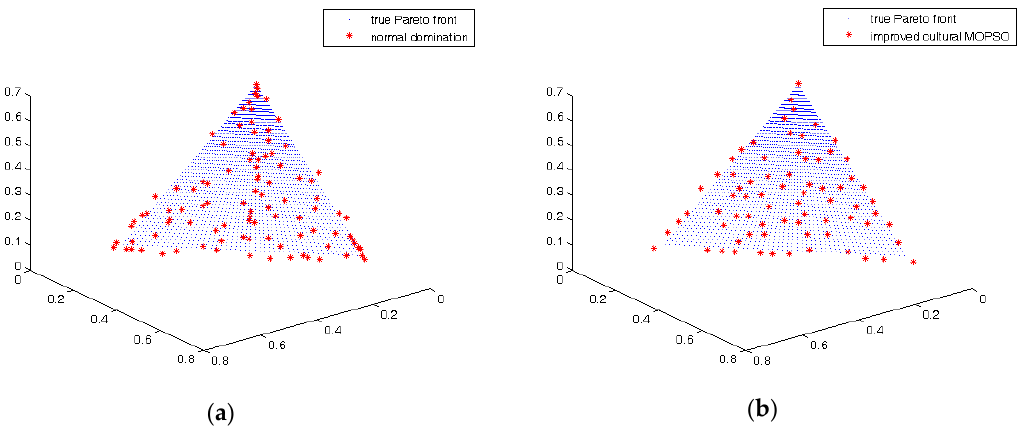
Figure 6. Pareto fronts for DTLZ1: ( a ) the Pareto fronts obtained using normal domination criterion; ( b ) the Pareto fronts obtained using hypercube-based ε -domination.